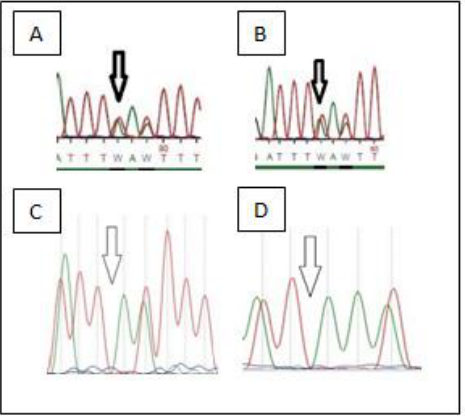
in Homozygous state. (fetus 2)